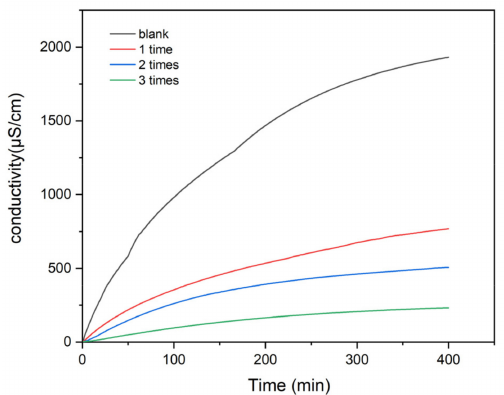
Figure 9. Conductivity results of the specimens before and after treatment.